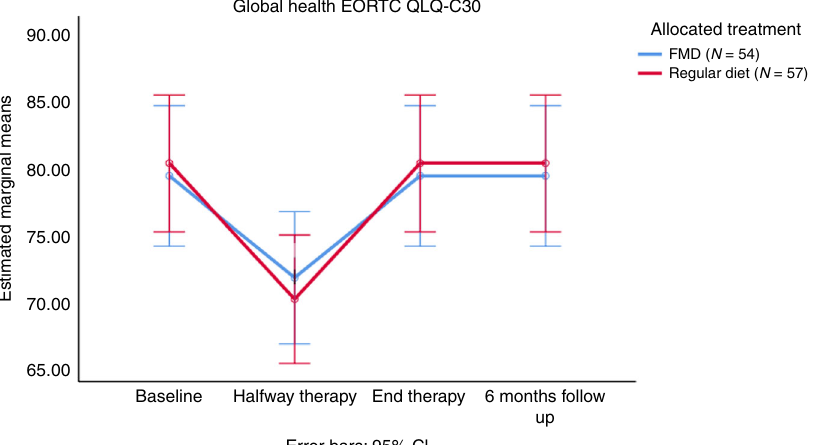
Fig. 3 EORTC QLQ-C30 global health domain given for 4 timepoints: before therapy (after randomization), halfway therapy, at the end of therapy and at six months follow-up. Error bars indicate the 95% CI of the mean. Abbreviations: EORTC: European Organization for Research and Treatment of Cancer, FMD: fasting mimicking diet. CI: con fi dence interval. FMD N = 57 and regular diet N = 54. Armitage ’ s trend test was used. Source data are provided as a Source Data fi